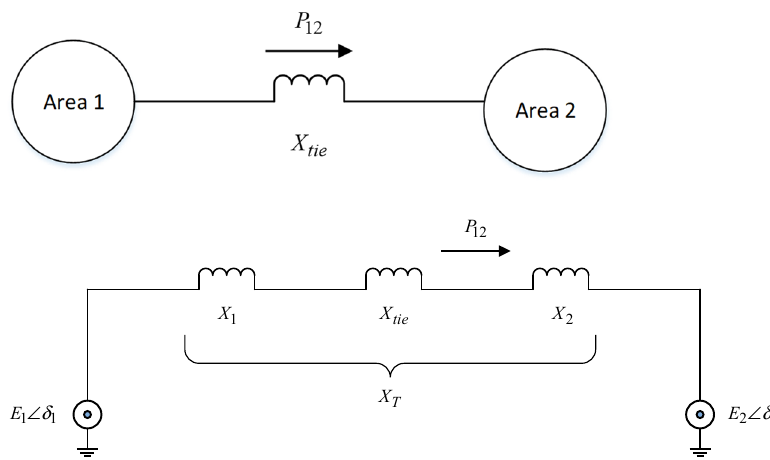
Figure 1. A two-area system and its electrical equivalent circuit representation.